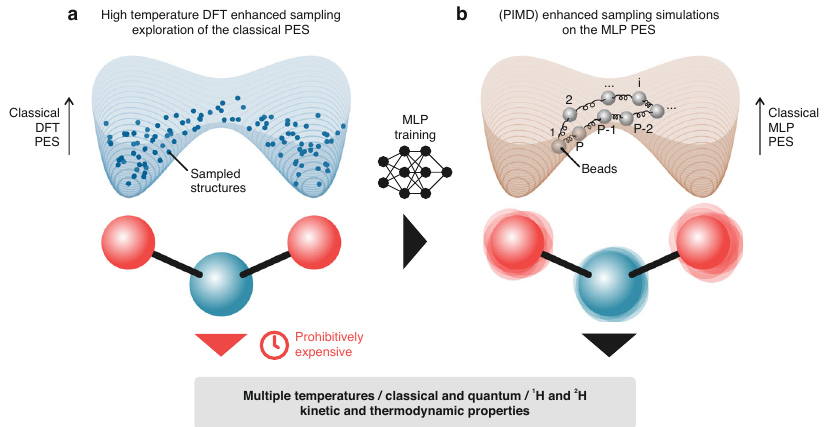
Fig. 2 | Kinetic and thermodynamic properties with and without NQEs over a wide range of temperatures can be computed using an MLP trained on high- temperature enhanced-sampling DFT simulations. The pictures show a simpli- fi edschematicrepresentationofthePESexperiencedbytheprotonwhenhopping